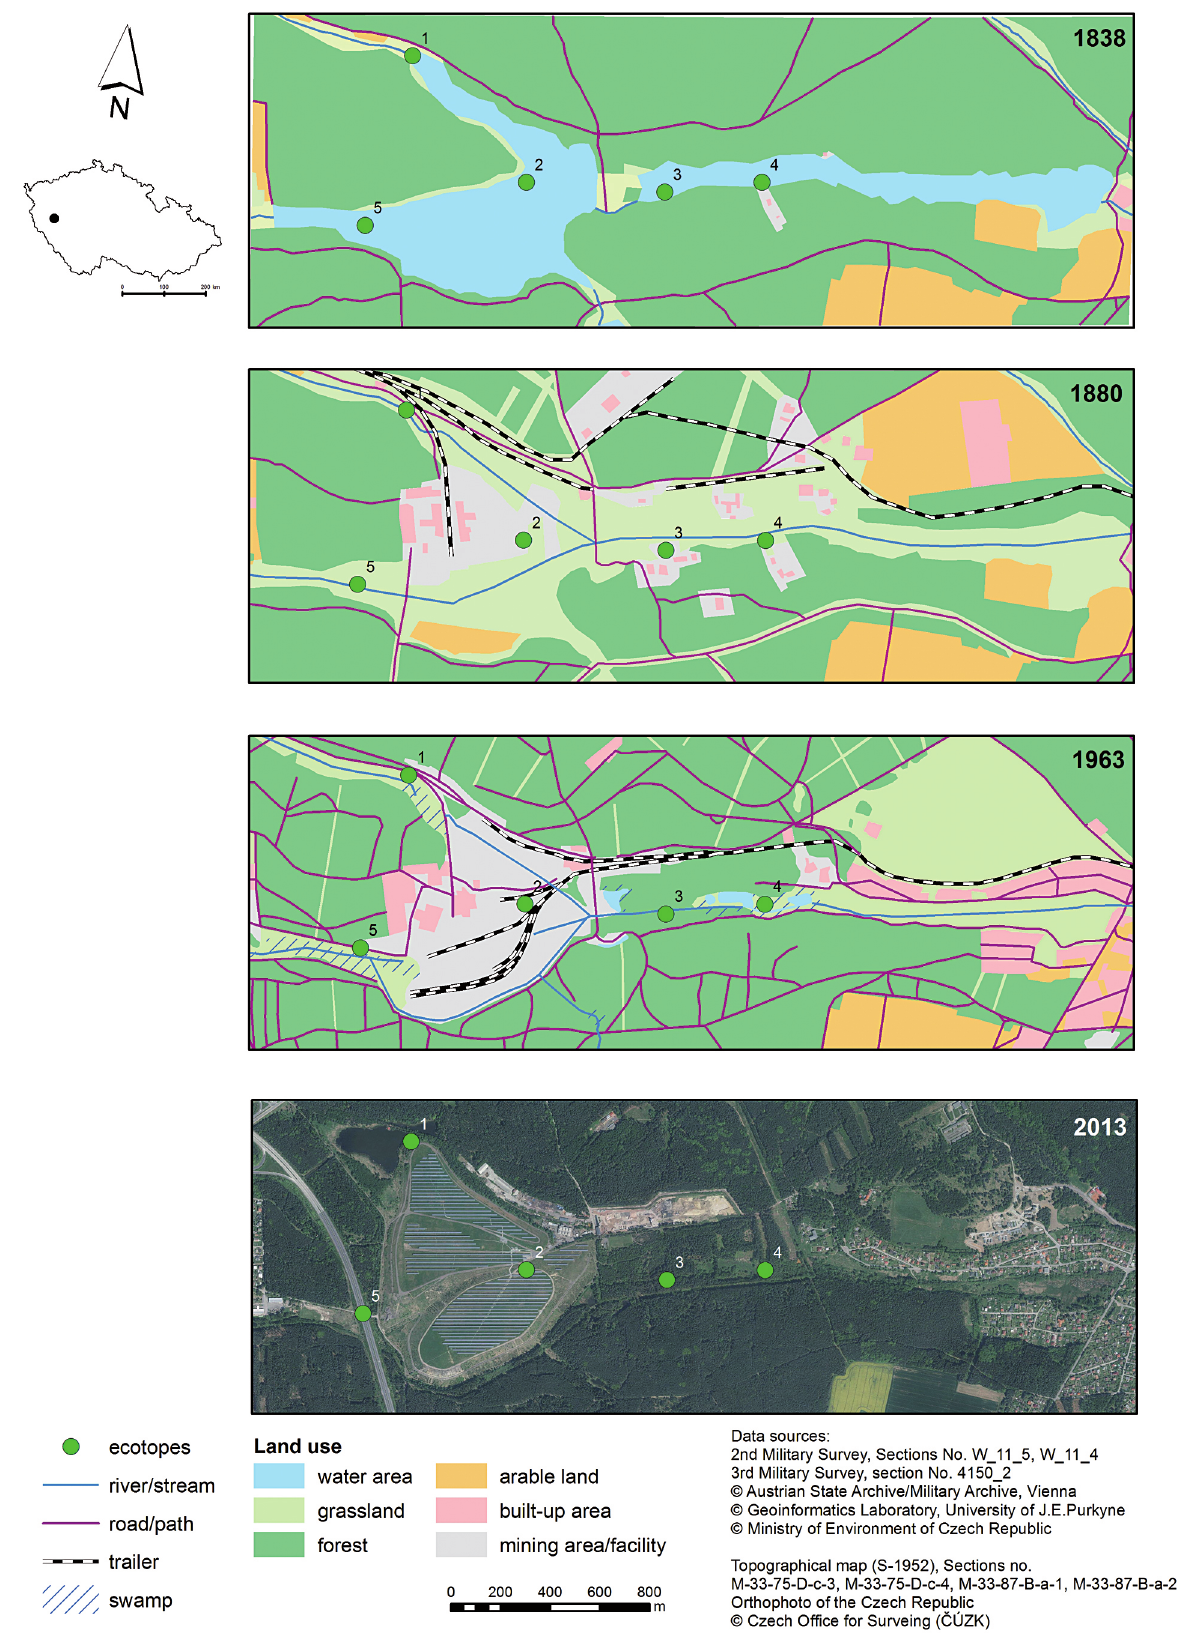
Fig. 2. Land use development (1838–2013) and location of ecotopes in the Sulkov